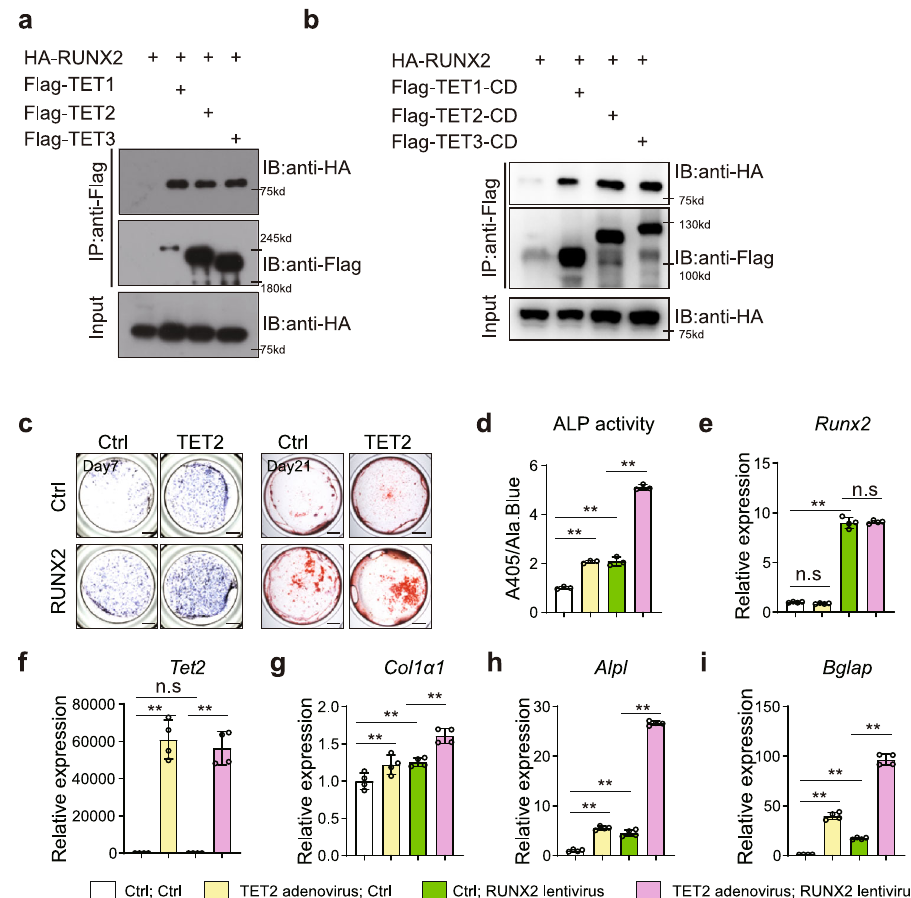
Fig. 6 | TET proteins associate with RUNX2 and promote osteogenesis with RUNX2 synergistically. a Co-immunoprecipitation (Co-IP) of Flag-TET1 or Flag- TET2 or Flag-TET3 with HA-RUNX2. HA-RUNX2 expressing plasmid was co- transfected with Flag-TET1 or Flag-TET2 or Flag-TET3 in 293T cells. Whole cell lysate was used for immunoprecipitation and then blotted with indicated anti- bodies. Representative images for two independent samples. b Co- immunoprecipitation (Co-IP) of Flag-TET1-CD or Flag-TET2-CD or Flag-TET3-CD withHA-RUNX2.HA-RUNX2expressingplasmidwasco-transfectedwithFlag-TET1- CD or Flag-TET2-CD or Flag-TET3-CD in 293T cells. Whole cell lysate was used for immune precipitation and then immunoblotting with indicated antibodies.